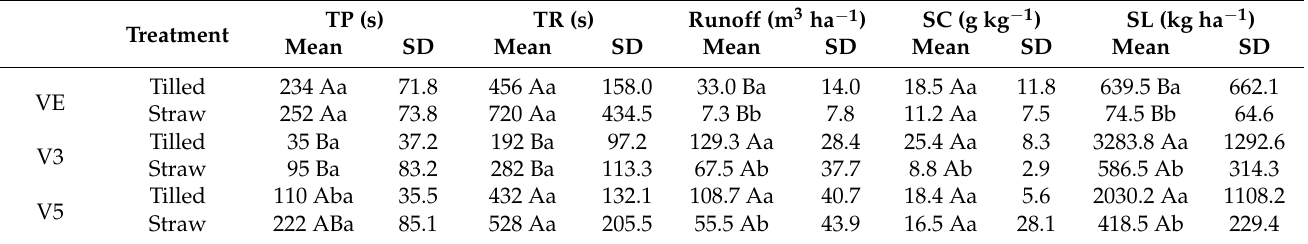
Table 3. Results of two-way ANOVA analysis considering overland flow properties. Different let- ters after mean values in the columns represent significant difference at p < 0.05. Capital letters show statistical difference between stage growth. Lower case letters show statistical differences between treatments. Abbreviations: WE—after seeding; V3—five-leaves stage; V5—intensive